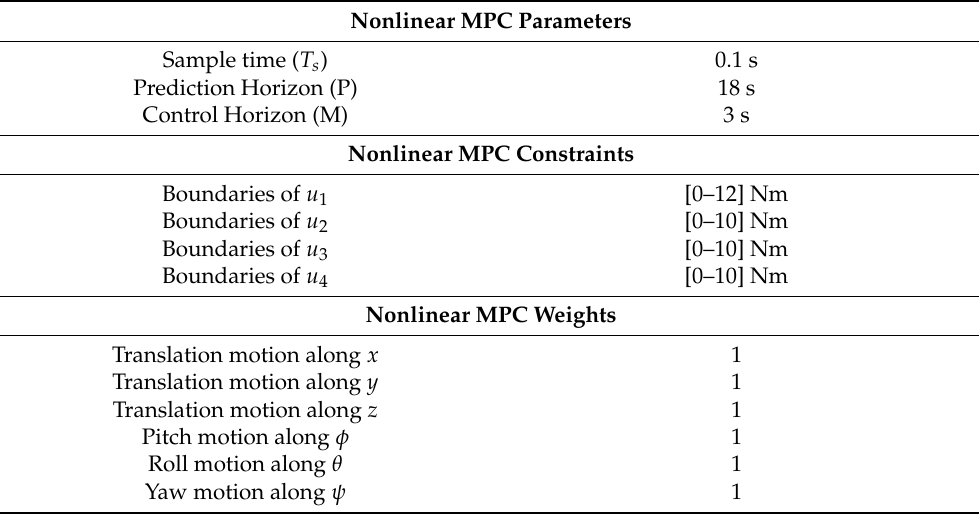
Table 4. The required parameters of nonlinear MPC for Tello